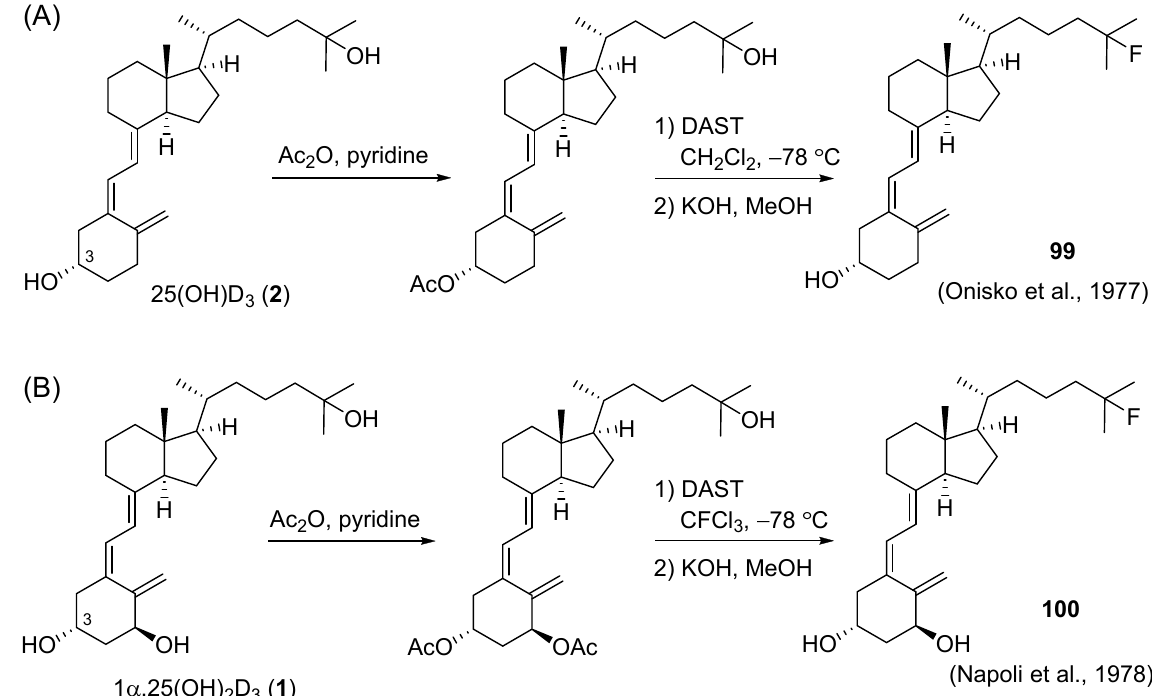
Scheme 34. Synthesis of 25-fluoro-VD 3 analogues via direct C25 fluorination from 25(OH)D 3 ( A ) and 1 α ,25(OH) 2 D 3 ( B ) using DAST as a fluorinating reagent.